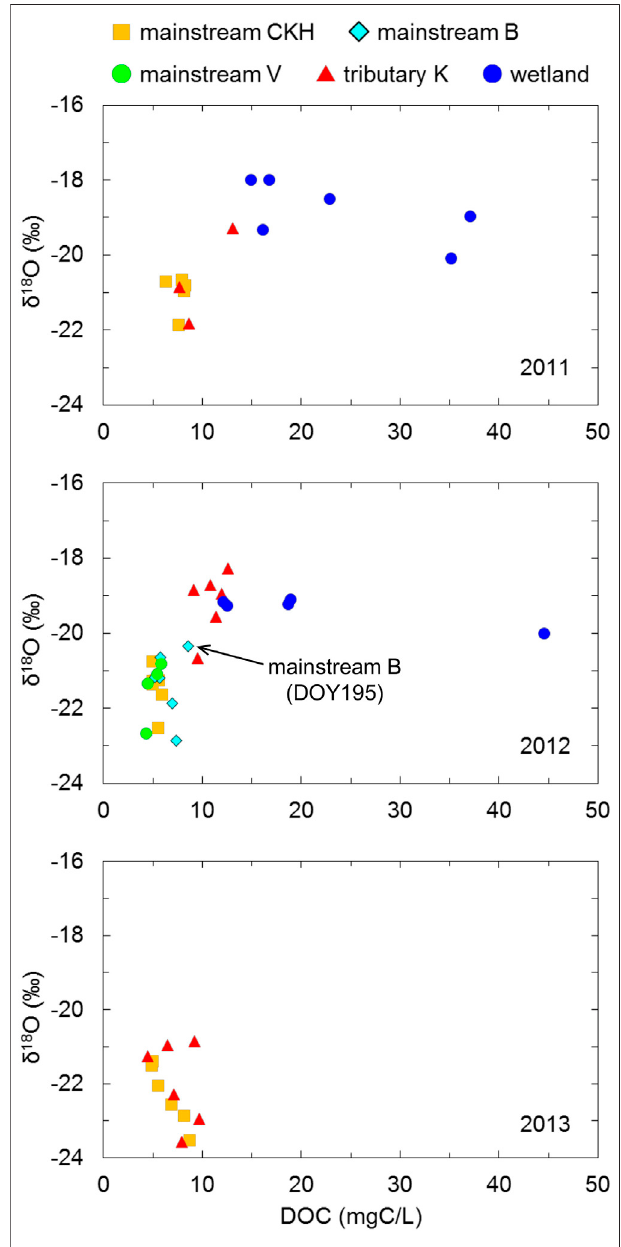
FIGURE 8| Relationship of δ 18 O and DOC concentration in the Indigirka mainstream, one tributary, and the wetlands. The mainstream samples were observed at sampling points CKH, B, and V, and the tributary samples were observed at point